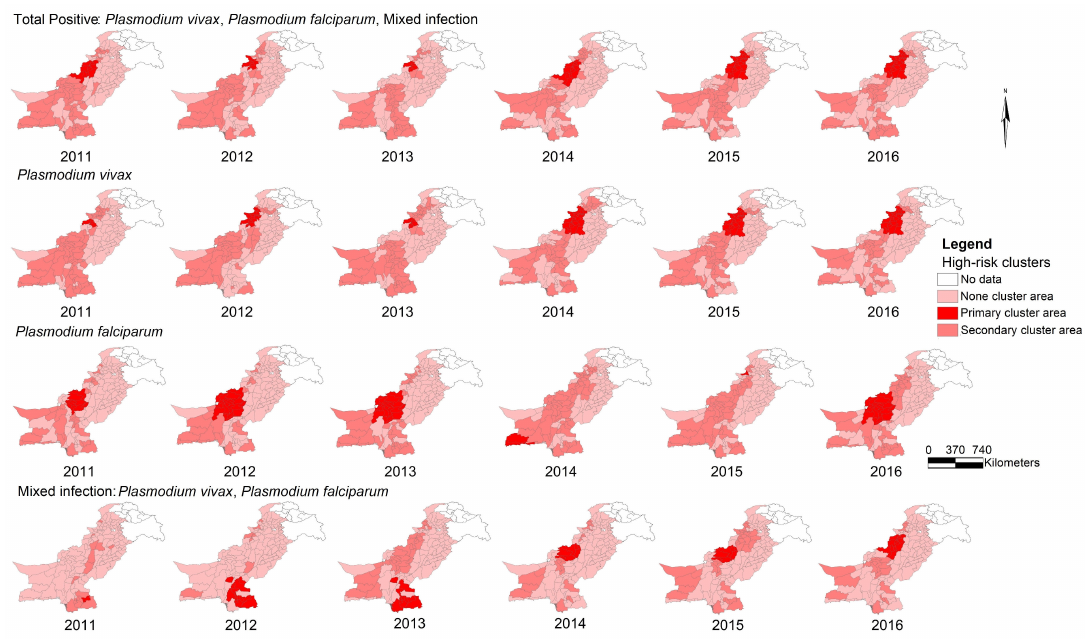
Figure 5. High-risk clusters of malaria by type at the district level in Pakistan, 2011–2016. Table 2 shows details about most significant high-risk districts (primary clusters) of the disease during the study period. It gives yearly information on number of districts, coordinates of centroid, radii, population, number of cases, IR, relative risk and statistical significance of the primary clusters of malaria by species. It was established that the number of cases and IRs of P . vivax malaria were much higher than those of the other two species of malaria ( P . falciparum and mixed Plasmodium ) in the respective years. Another important finding is that the districts (number and locations) in primary clusters of (i) P . vivax are same for 2014, 2015 and 2016 (total 24 districts, 12 in FATA, 9 in KPK, 2 in Punjab and 1 in Balochistan); (ii) P . falciparum are same for 2012 and 2013 (total 18 districts, all in Balochistan); (iii) mixed Plasmodium are same for 2014 and 2015 (total 7 districts, 6 in Balochistan and 1 in FATA). We also tested spatial cluster analysis using other parameters (100 km, 300 km and 400 km for maximum radius of cluster, and 5%, 15% for maximum population at risk) and did not find significant differences from the above